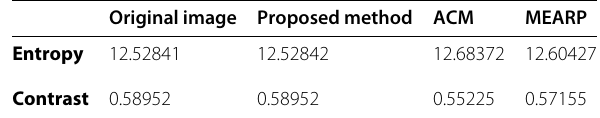
Table 1 Comparison of simulated imaging results under a